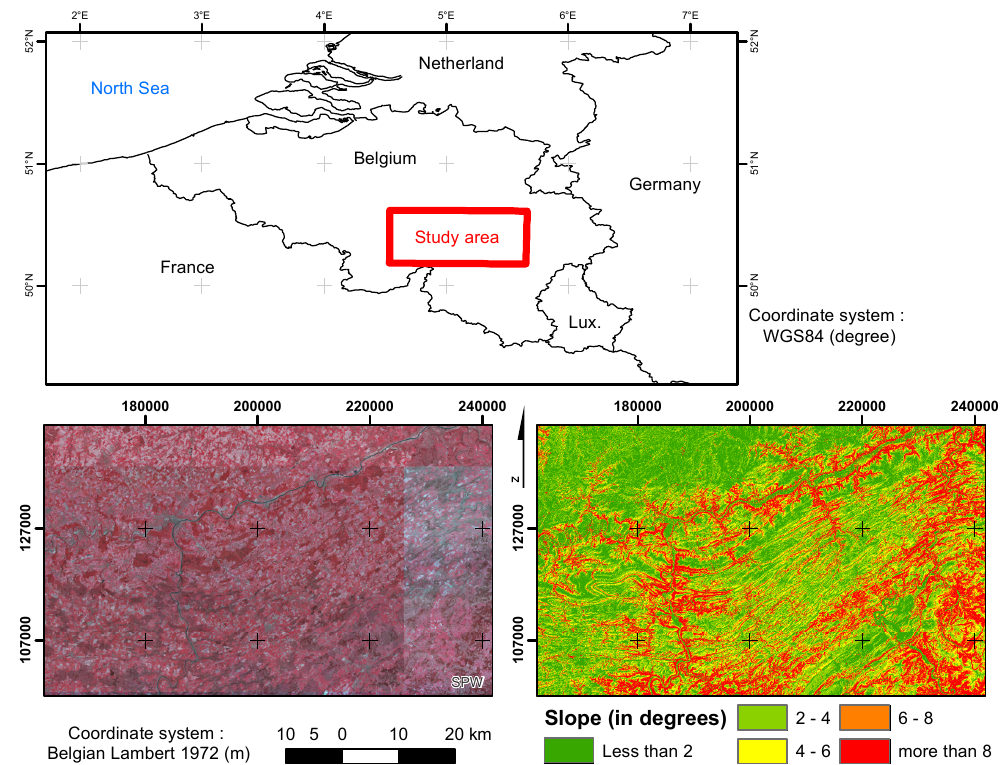
Figure 1. Aerial orthophoto ( left ) and slope derived from the LIDAR images ( right ) on the study area. Two types of input data were available in the study area. First, a mosaic of ortho-rectified aerial photographs upscaled to 2 m resolution and including four spectral bands; Second, a LIDAR point cloud dataset rasterized at 2 m